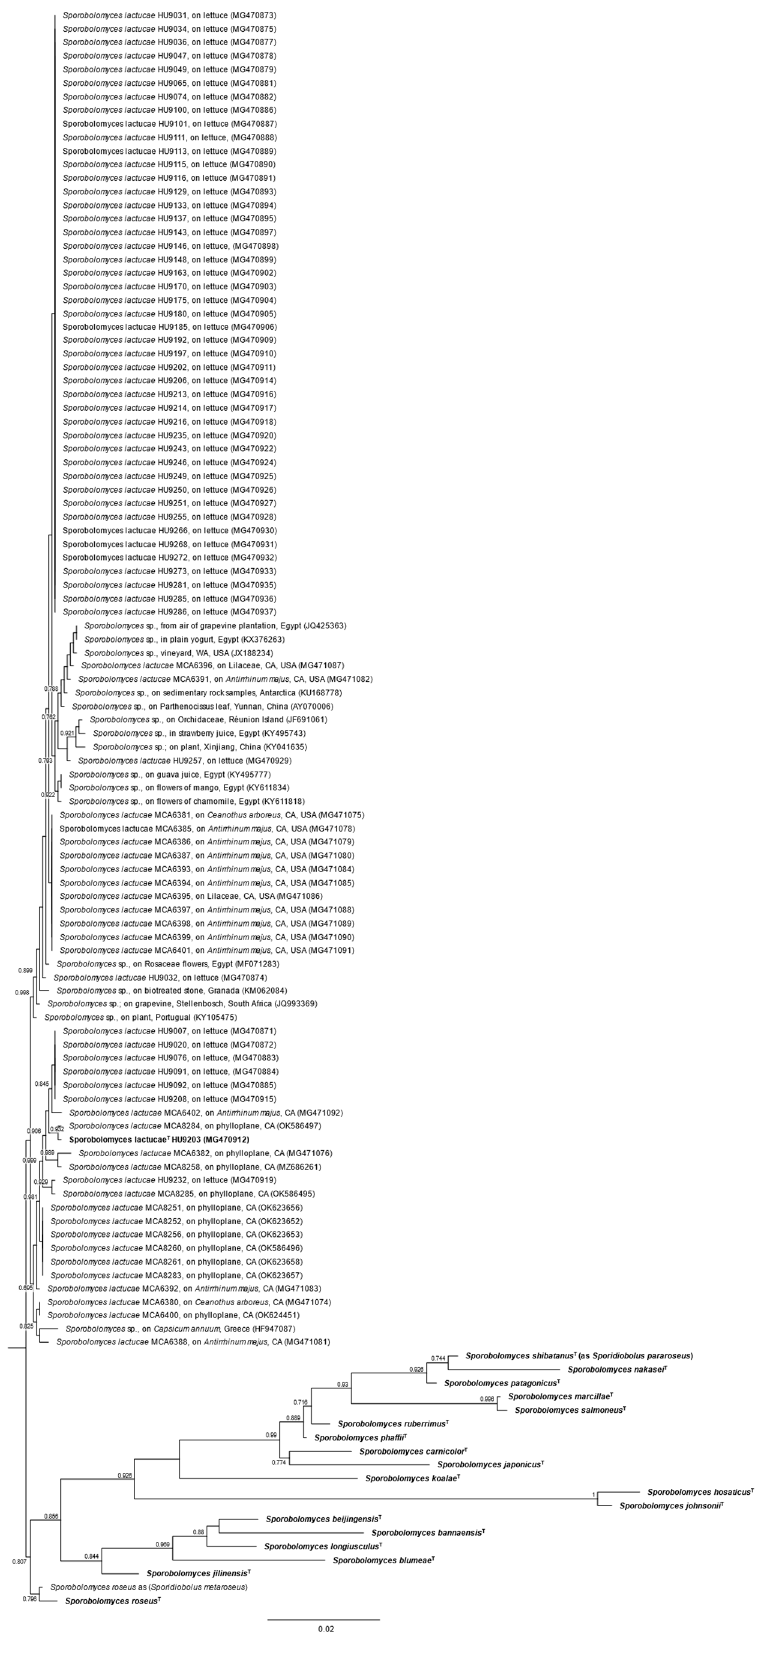
Figure 2. Phylogeny of environmental Sporobolomyces lactucae sequences reconstructed from ITS dataset. Sporobolomyces s.s. ex-type sequences are indicated with T .